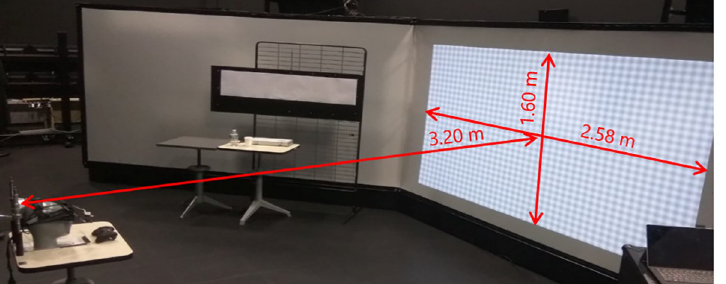
Fig 1. The experimental setup. The participant was seated 3.20m from a screen 1.6m high and 2.58m wide. The HSF 100% condition is captured in this